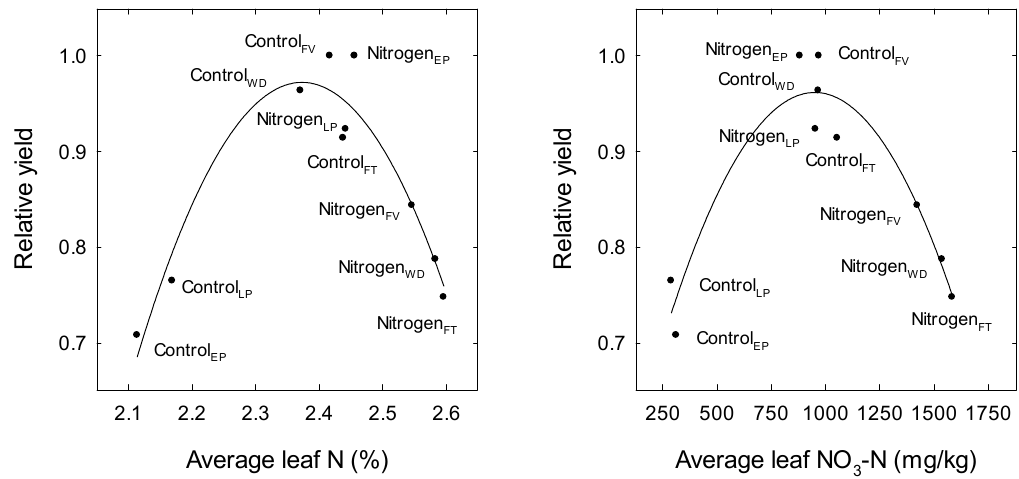
Figure 4. Relationship between relative yield and the average seasonal concentration of total nitrogen (N) and nitrate-N (NO 3 -N) in young, fully expanded leaves of strawberry plants grown in Queensland, Australia in 2014 and 2015. Each symbol represents the mean of four or six replicates per treatment. Control = no nitrogen; Nitrogen = fertilised with nitrogen; FV = Festival; FT = Fortuna; WD = Winter Dawn; EP = early planting; and LP = late planting. Leaf N: relative yield = 23.12 + 20.3 × leaf N − 4.27 × (leaf N) 2 ( R 2 = 0.90). Leaf NO 3 -N: relative yield = 0.4852 + 0.0010 × leaf NO 3 -N − 0.0000005 × (leaf NO 3 -N) 2 ( R 2 = 0.89).